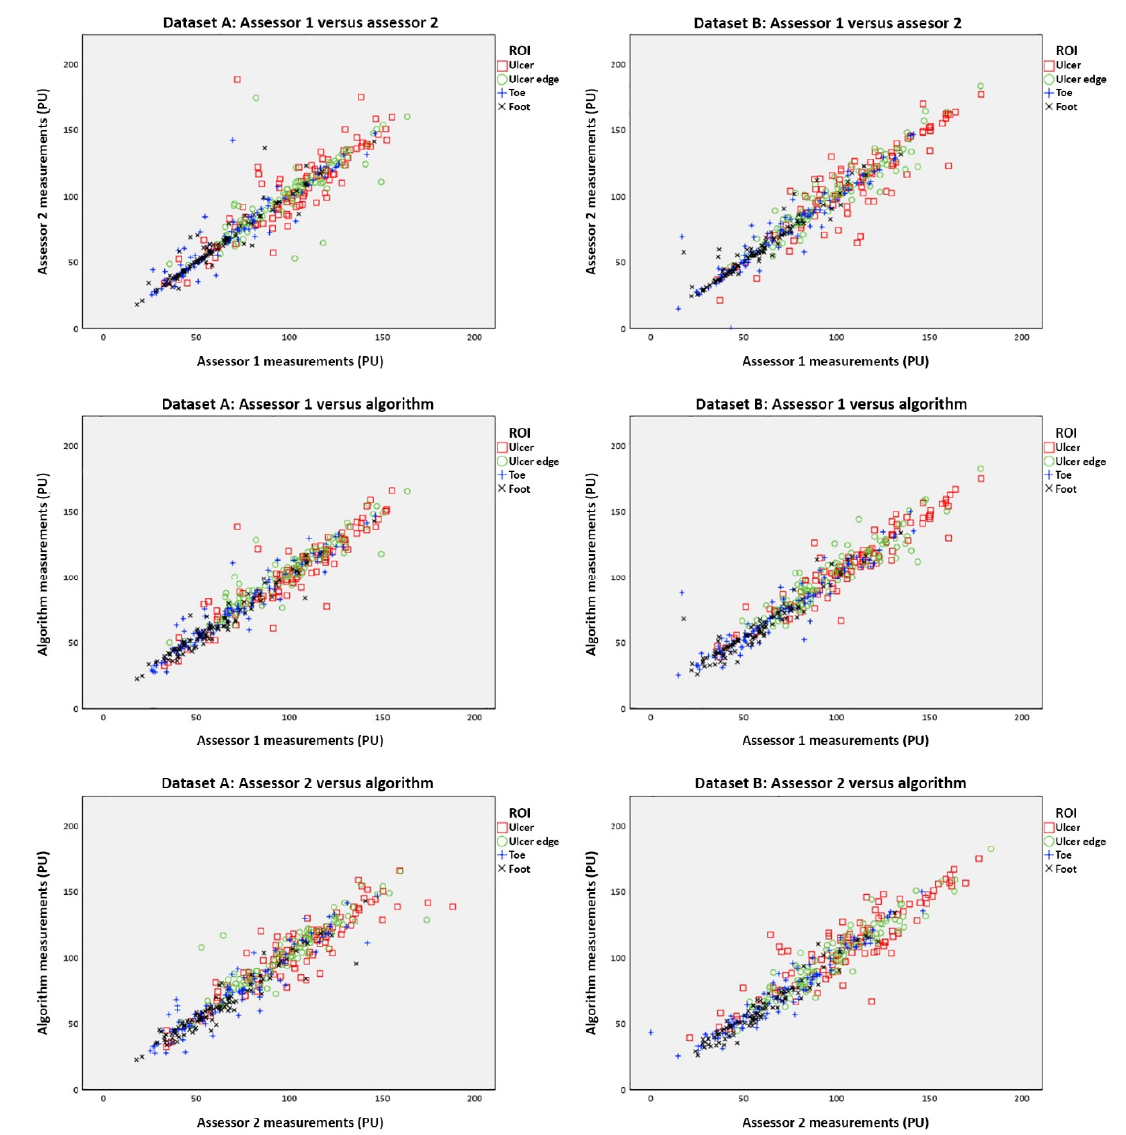
Figure 8. Scatterplots of the measurements between assessors and the algorithm. Perfusions are shown in Perfusion Units (PU) for all scans during baseline measurements and different stress tests. Recordings were obtained with Laser Speckle Contrast Imaging by operator A (Dataset A) and operator B (Dataset B), and analyzed by two assessors and the algorithm. Assessors 1 and 2 and the algorithm were compared to each other for different regions of interest (ROIs).